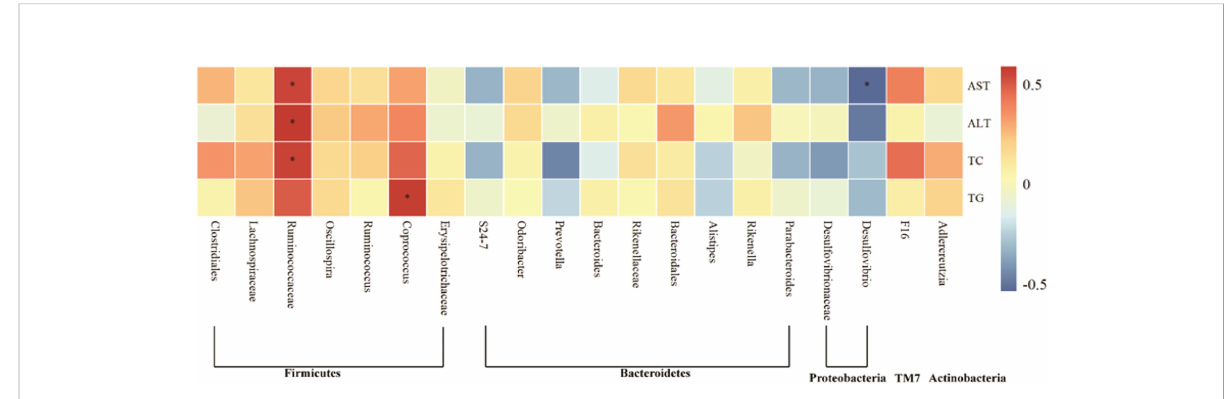
FIGURE 7 Heat map of the correlation of gut microbiota with indicators of liver injury in AFLD mice. Signi fi cant differences are indicated by asterisks, * P <